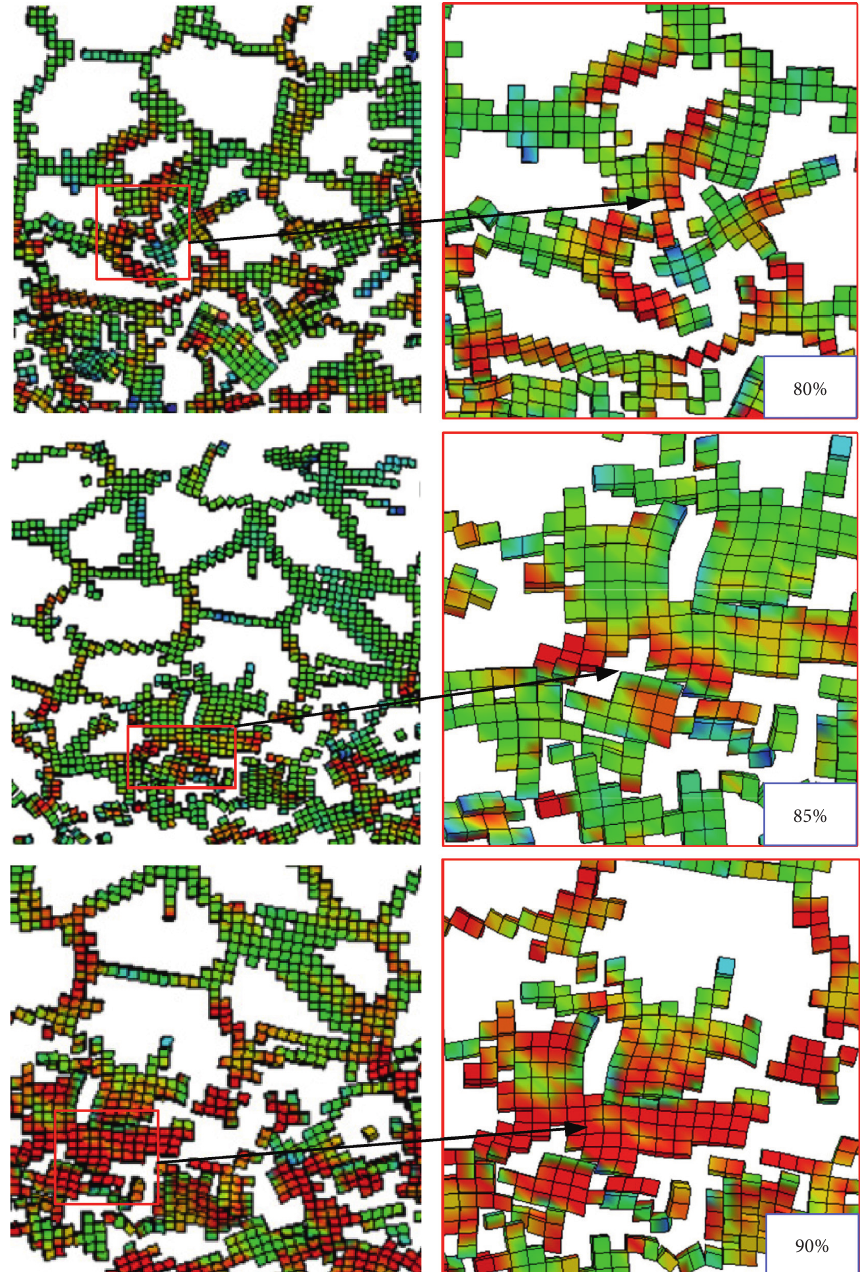
Figure 16: Cell wall collapse and